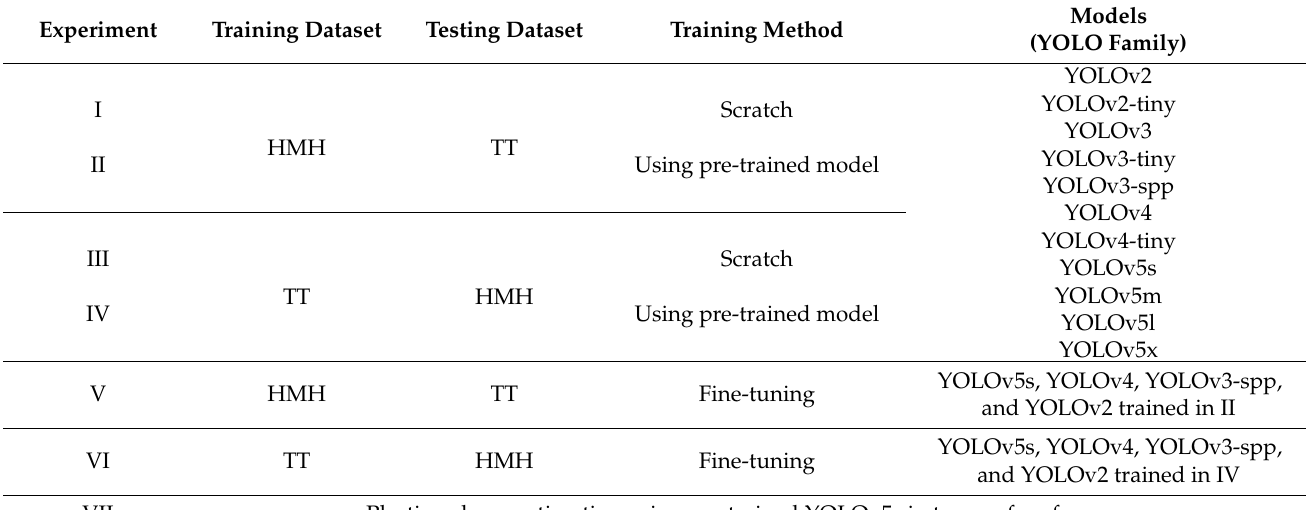
Table 2. Plastic detection experiment details using Houay Mak Hiao river (HMH) and Khlong Nueng Canal (TT)